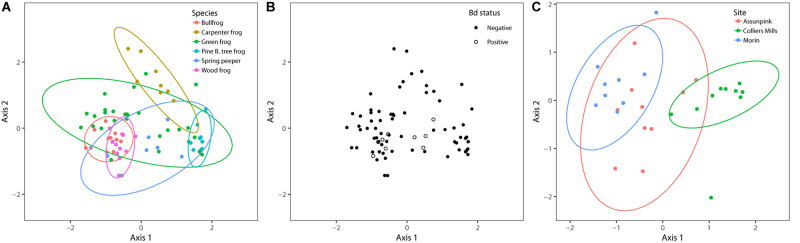
NMDS plots of bacterial communities based on Bray–Curtis distances and grouped by (A) frog species, (B) Bd status, and (C) sampling site. Each point represents an individual amphibian’s skin bacterial community. The ordination used for host species and Bd status contains all individuals sampled (k = 3, stress = 0.15), and the ordination used to compare sampling sites only includes green frogs (k = 3, stress = 0.12), the only species to be sampled at more than two sites. PERMANOVA results indicated that sampling site and species (p < 0.05) but not Bd status (p > 0.05) influenced bacterial community beta diversity.